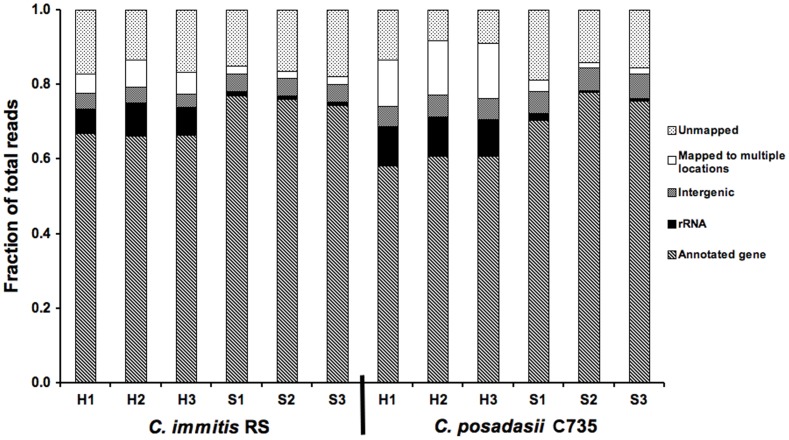
Library mapping summary.Per-lane read proportions for all libraries. H: hyphae (saprobic phase), S: spherule (parasitic phase).